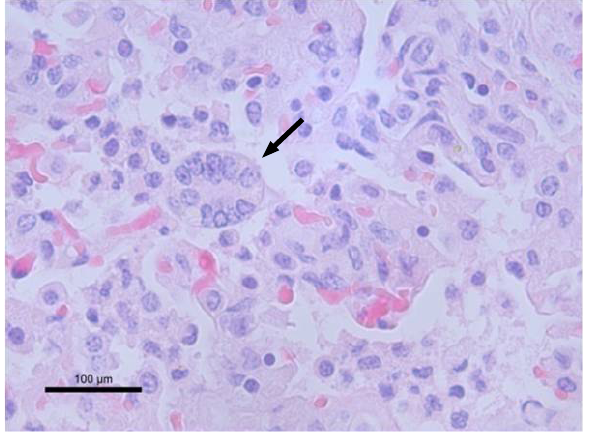
Figure 1. Aborted equine fetal lung tissue (Fetus 2). Syncytium of alveolar pneumocytes (arrow). Scale bar 100µm. H&E.